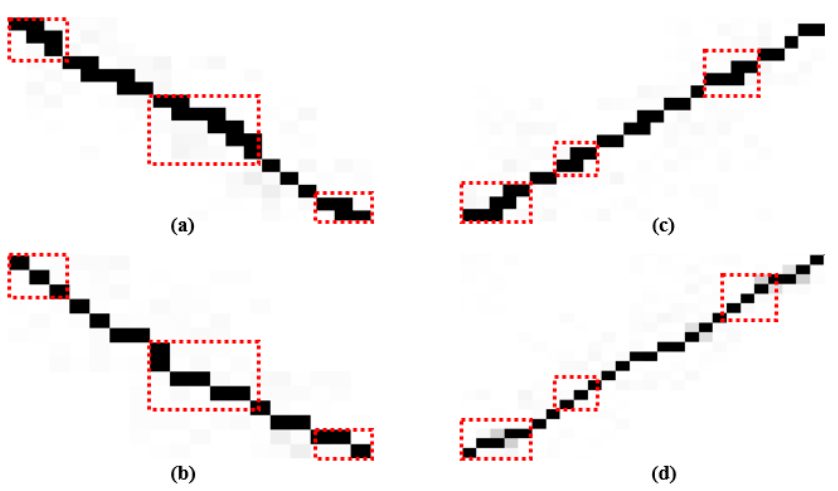
Figure 9. Single pixel rendering after macro-magnification. ( a , c ) is the original refinement results with the overlapping pixels, ( b , d ) is corresponding the refinement results for a single pixel.